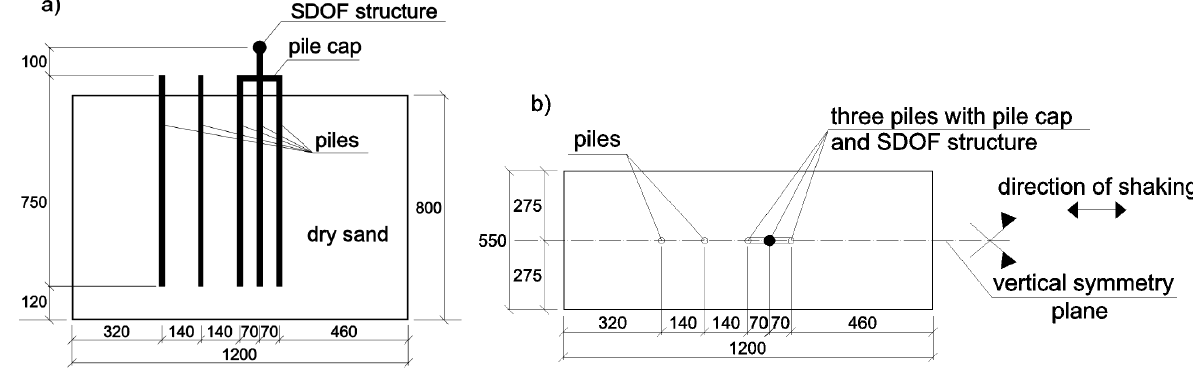
Figure 1: Geometry of numerically modelled experimental setup with a single degree of freedom (SDOF) structure: a) long side view, b) plan (dimensions in mm).